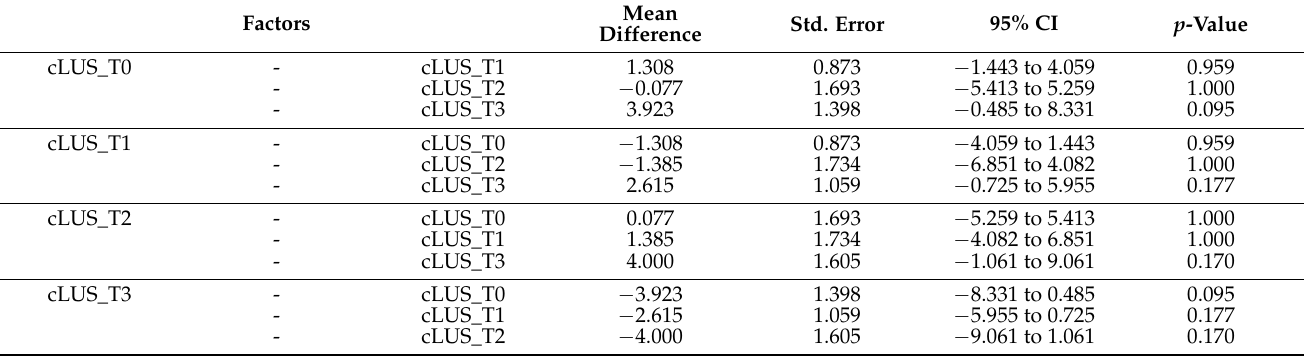
Table 4. Pairwise comparisons between contralateral CDH-LUS (cLUS) scores at different time points with a Bonferroni post hoc